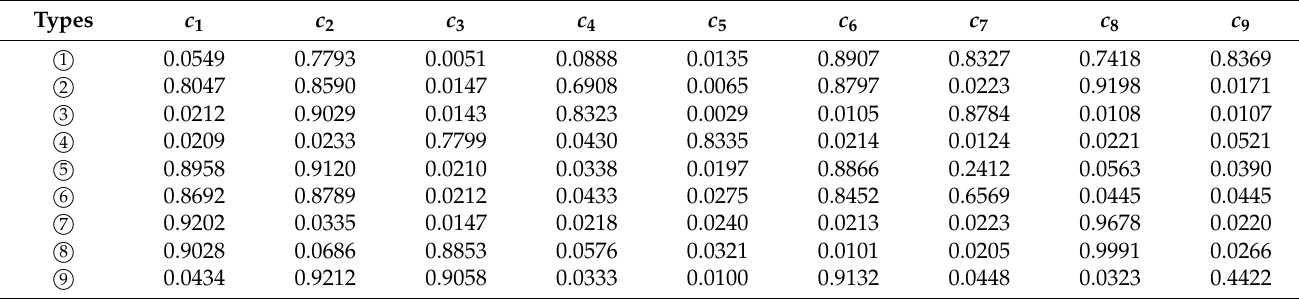
Table 7. Cluster centers of nine fault types.